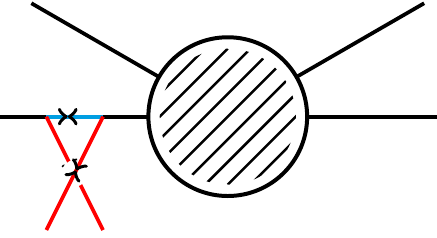
Figure 5 . Feynman diagram for double soft gravitini |